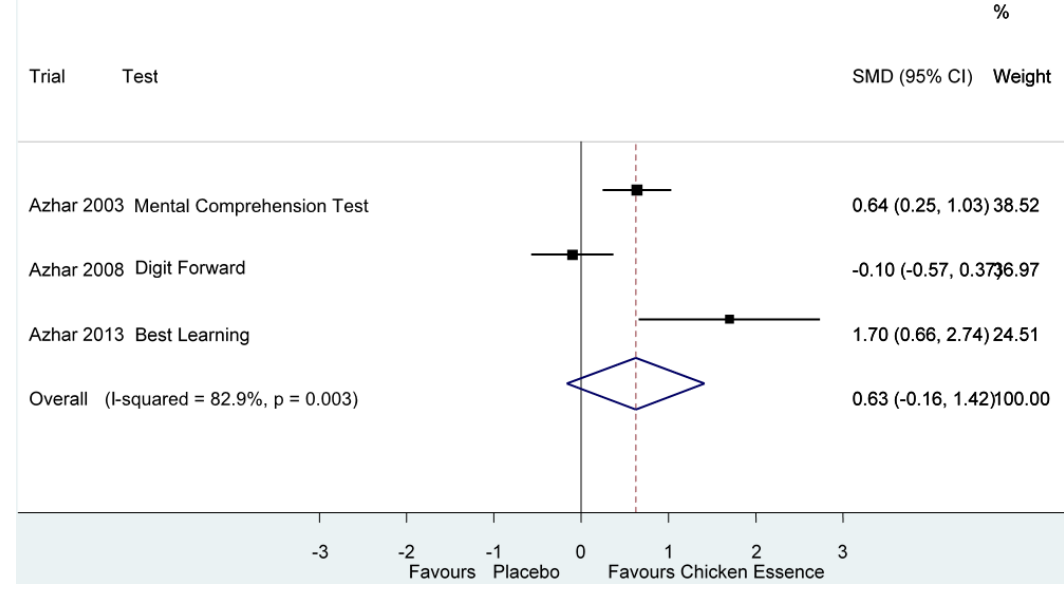
Figure C3. Pooled effect estimate of score of short-term memory tests.